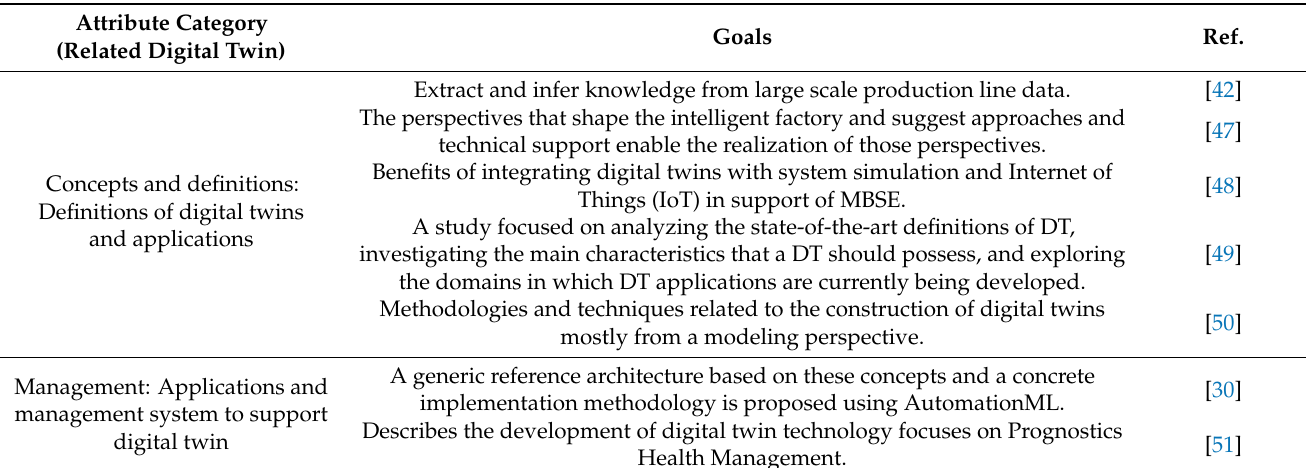
Table 2. Areas of digital